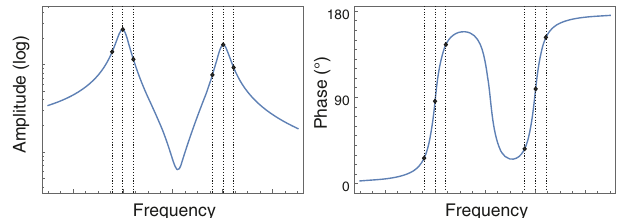
FIG. 13. Principle of multifrequency response. The nanowire is simultaneously driven by the intracavity field at six different frequencies, in order to accelerate the measurement time of the local force vector. Three tones are driving each eigenmode, the central tone of which is locked on the eigenmode resonance, while the two sidebands are separated by 50 Hz, which is comparable to the eigenmode linewidth. Recording the ampli- tudes and dephasing for each tone permits us to determine the quality factors and eigenmode frequencies, as well as the local complex driving force vector.